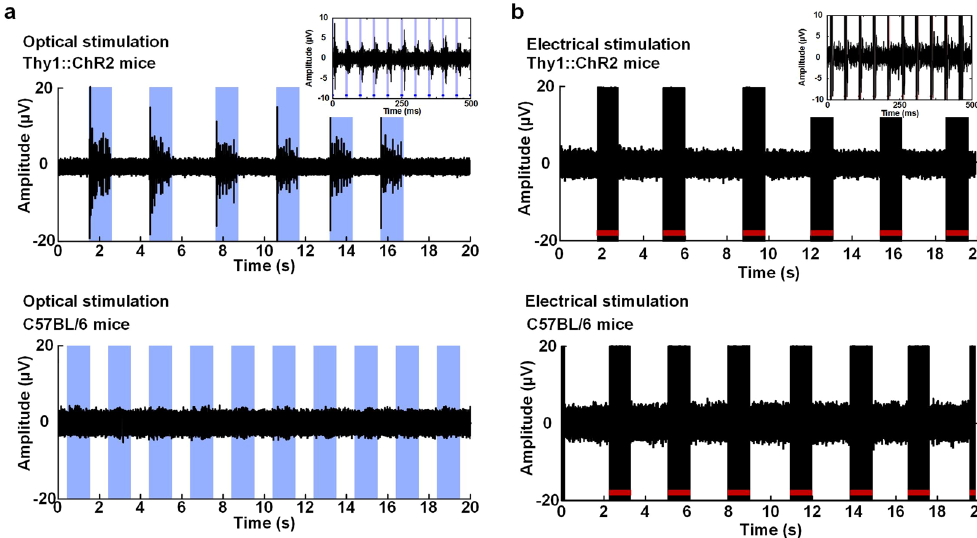
Figure 5. Neural activity monitoring in Thy1::ChR2 and C57BL/6 mice. ( a ) Neural activity monitoring during optical stimulation. ( b ) Neural activity monitoring during electrical stimulation. The blue bars indicate the optical stimulation periods. The red bars indicate the electrical stimulation periods.